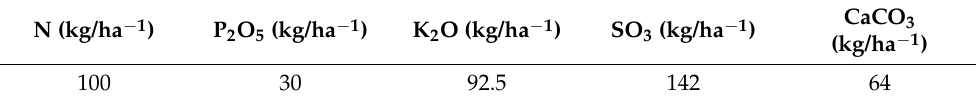
Table 3. Sum of nutrients used in the experiment in all assessed treatments